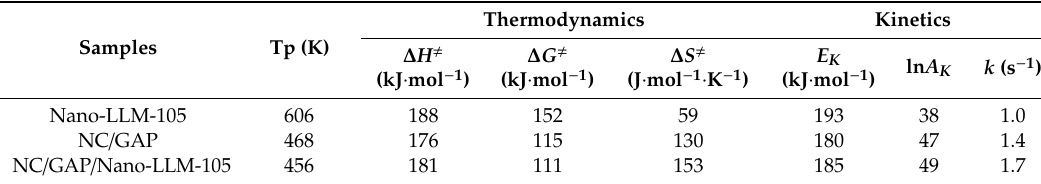
Table 3. Thermodynamics and kinetics deduced from DSC traces.